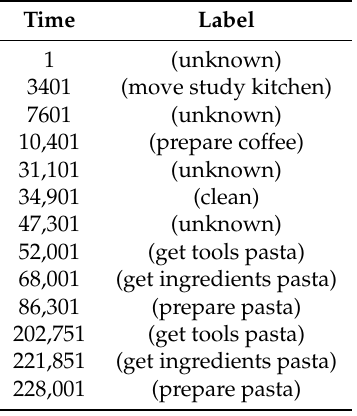
Table 5. Excerpt of the annotation for run D1. Time here is given in